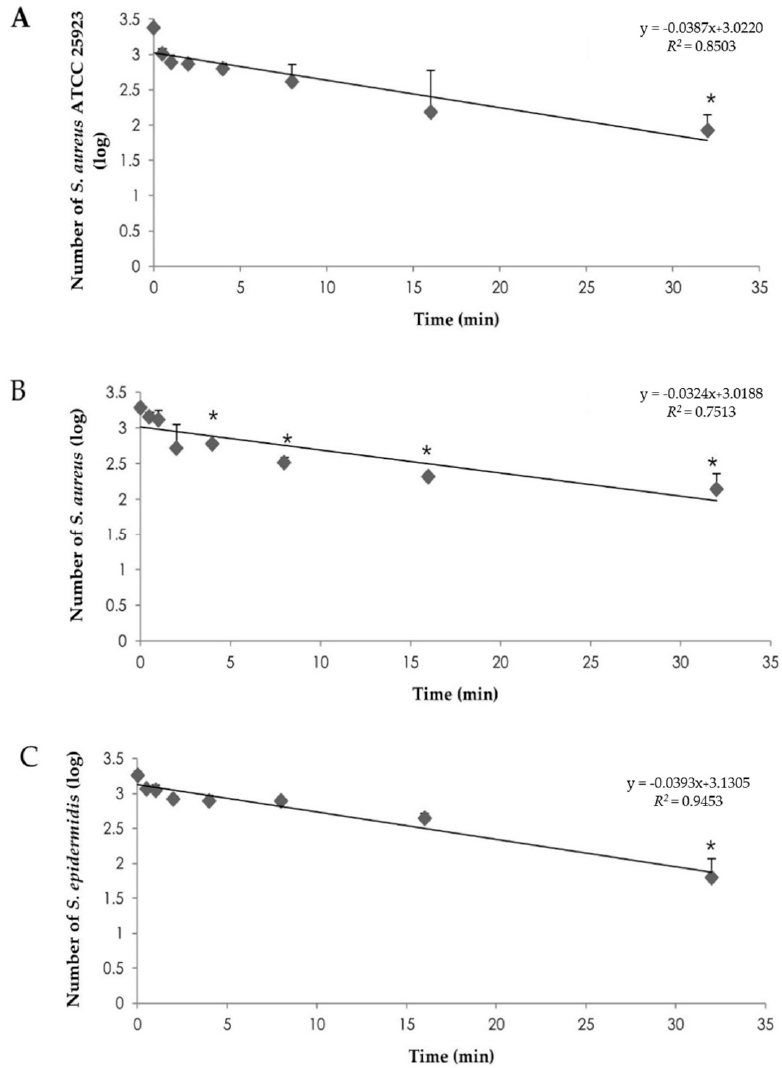
Figure 3. The killing rate of S. aureus ATCC 25923 ( A ); S. aureus field strain ( B ) and S. epidermidis field straind ( C ) with LA against bovine teat skin bacteria. Vertical bars represented the mean ± S.D. The line shown is the graph of the linear equation. Asterisk (*) means the significant differences of bacterial count at p ≤ 0.05.